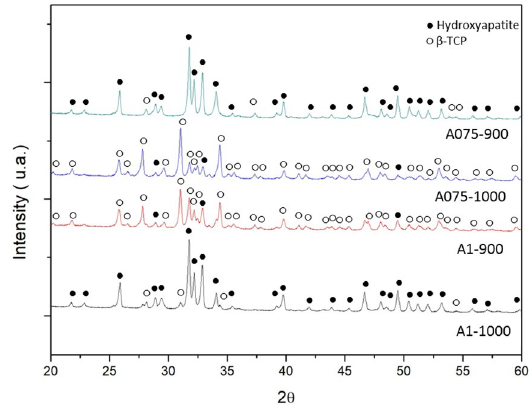
Figure 2. XRD patterns of the obtained